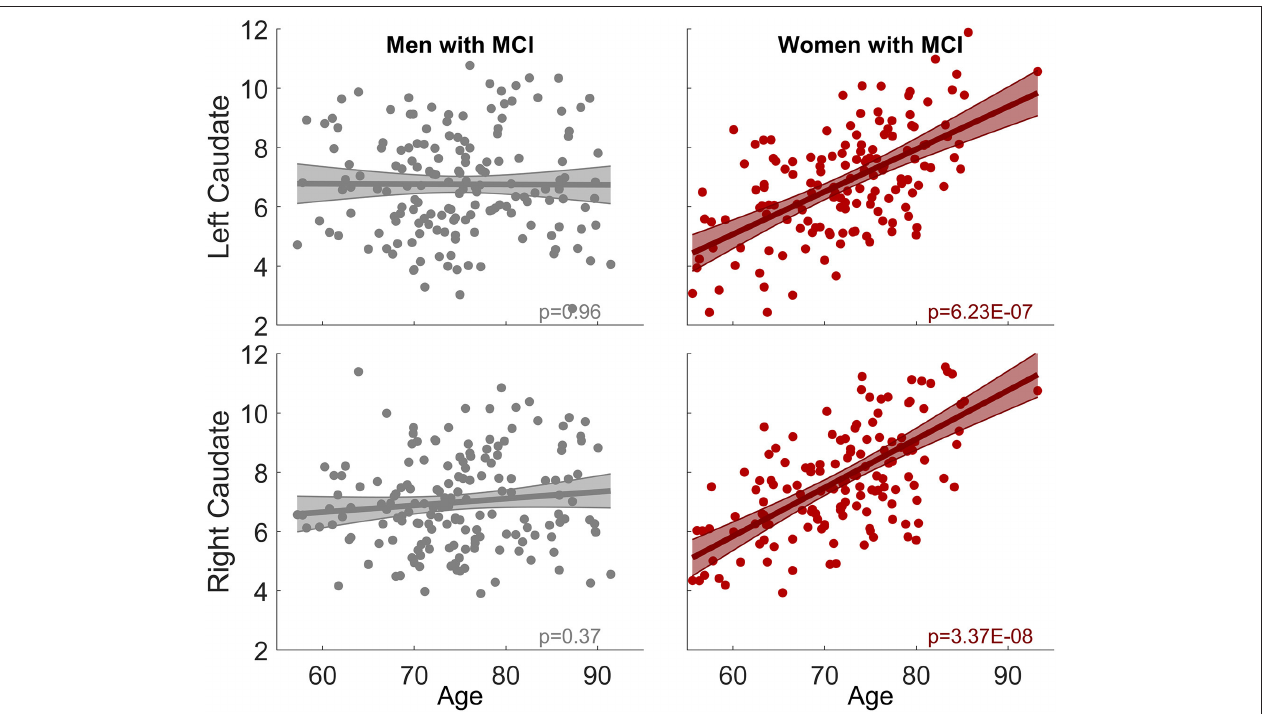
FIGURE 2 | Sex-dependent association between caudate nodal strength and age among MCI group. No association is observed in men for both right and left caudate. In contrast, significant positive association is observed in women (left: p = 6.23 × 10 − 7 , right: p = 3.37 × 10 − 8 ). The same analysis among CN group is shown in Supplementary Figure 1